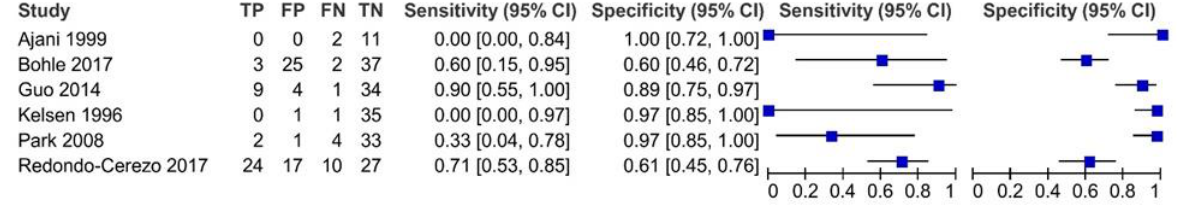
Figure 8. Forest plot for T4 restaging.